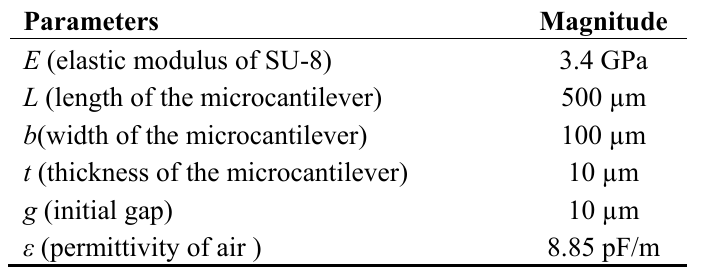
Table 2. Values of the parameters of the reference microcantilever